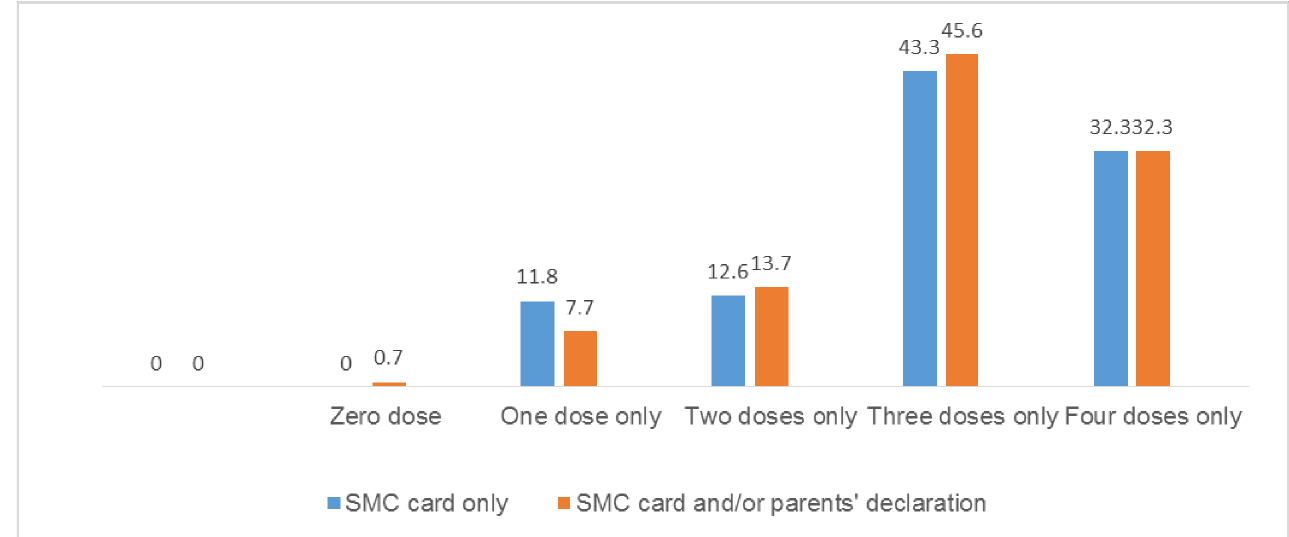
Fig 5. Total number of DOT doses receivedby the SMC target population during the 2015 campaign in Kaya health district.